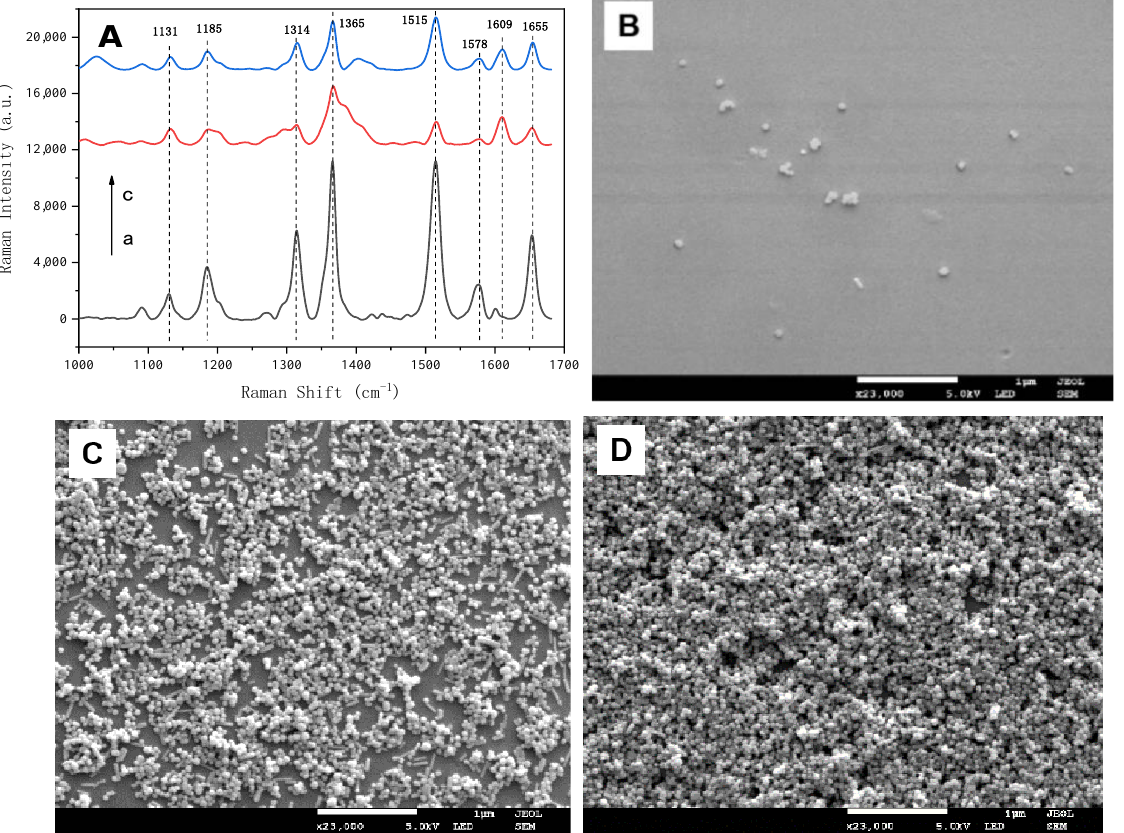
Figure 2. ( A ). SERS spectrum of R6G – ethanol solution with a concentration of 10 μM detected by RGB-SERS substrates with different deposition rounds. Spectra (a) to (c) represent the deposition of silver nanoparticles in 1, 2, and 3 rounds, respectively. Laser power: 13.8 MW; integration time: 1 s × 1; objective lens: 20 × . ( B – D ). SEM images of Ag-NP-deposited HRGBs; ( B – D ) represents 1, 2, and 3 rounds,